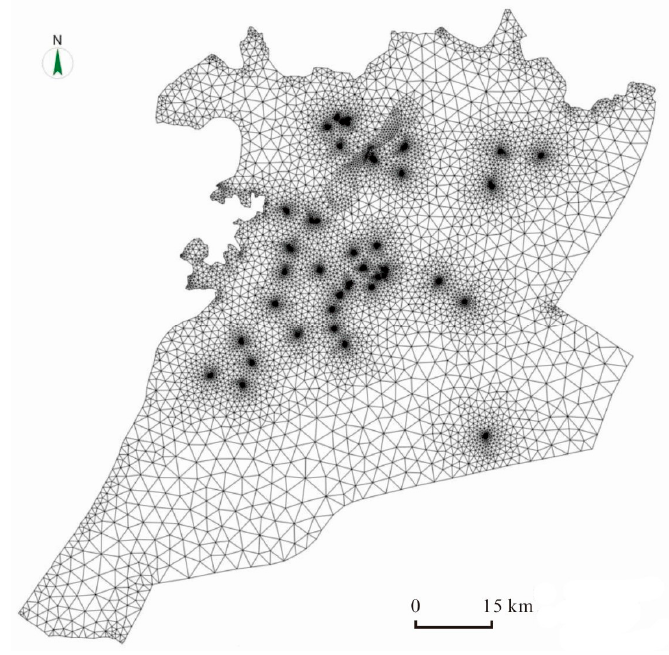
Figure 12. Discretization in a plane of the simulation area.